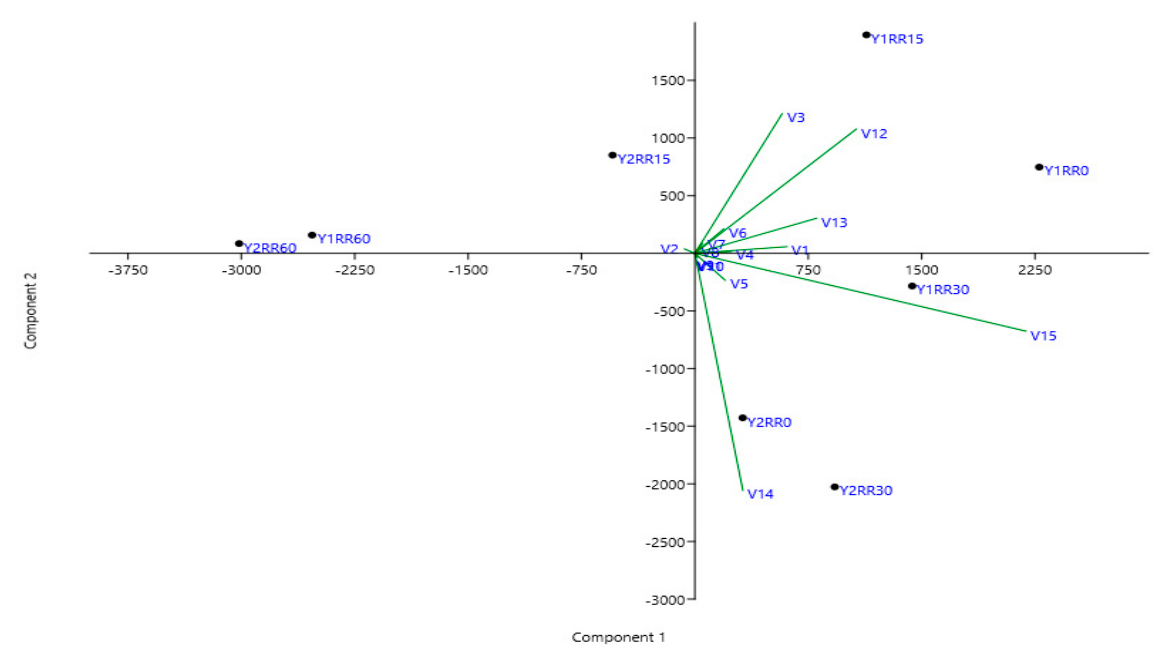
Figure 5. Principal component analysis (PCA) of ANPP of various species and functional groups in 2017 and 2018: V1 = Eragrostis curvula, V2 = Cynodon dactylon , V3 = Digitaria eriantha , V4 = Setaria nigrirostis , V5 = Themeda triandra, V6 = Heteropogon contortus, V7 = Setaria sphacelata , V8 = Eragrostis barbinodis , V9 = Melinis repens, V10 = Brachiaria serrata, V11 = Aritida congesta, V12 = decreaser, V13 = increaser, V14 = forbs, V15 = total ANPP, Y1RR0 and Y2RR0 = 0% RR in 2017 and 2018, respectively, Y1RR15 and Y2RR15 = 15% RR in 2017 and 2018, respectively, Y1RR30 and Y2RR30 = 30% RR in 2017 and 2018, respectively, Y1RR60 and Y2RR60 = 60% RR in 2017 and 2018,